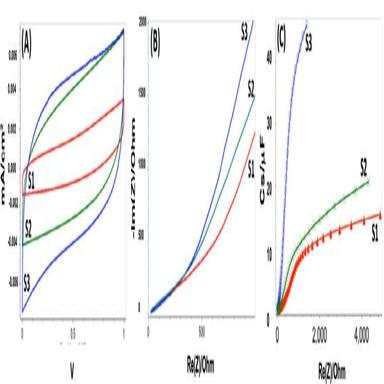
A: Variation of the specific capacitance of S3 electrodes as a function of cycle number measured at 100 mV/s; B: GCD curve of S3 at 100 µA/cm2 .